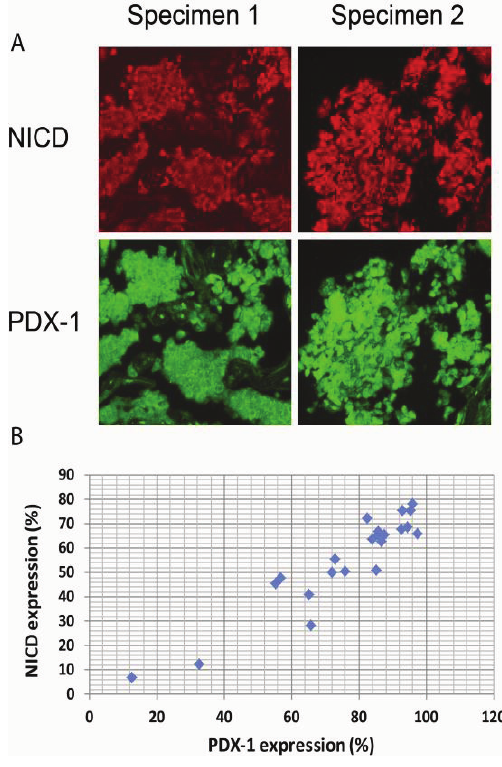
Figure 4. Activation of Notch1 is associated with PDX-1 overexpression in human PNETs. Human PNET specimens were fixed in 4% (v/v) paraformaldehyde and embedded in paraffin. After deparaffinization in xylene and rehydration through graded alcohol, tissue sections were incubated with an anti-NICD (1:100) or an anti-PDX-1 antibody (1:200) overnight at 4 °C. Fluorescence was developed using FITC- or Cy3-conjugated secondary antibody. Simultaneous fluorescence microscopy observation and photography were carried out using an Olympus IX70 microscope (200×). ( A ) Shown are representative micrographs showing the expression levels of NICD and PDX-1 in PNET specimens. ( B ) Pearson correlations analysis showed significant correlation between PDX-1 and NICD expression in these specimens, R = 0.933; p <